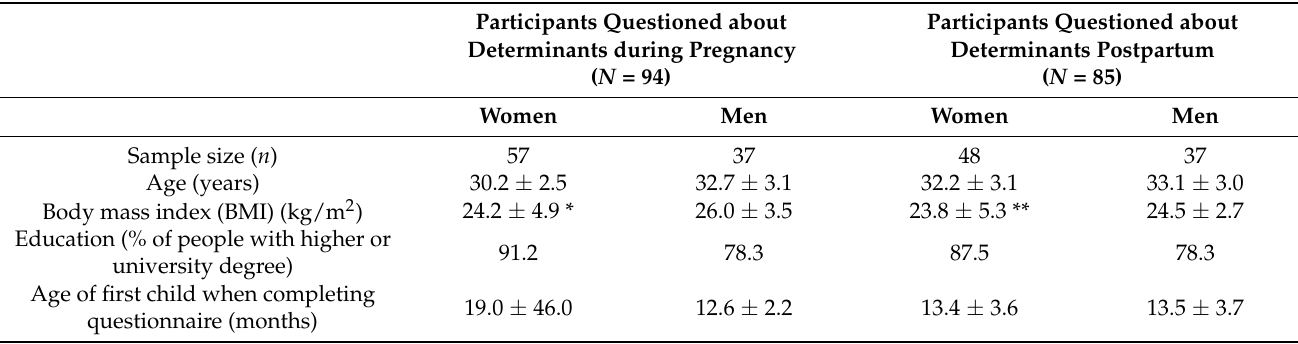
Figure 3. Parents’ rating of determinants of changes in eating behavior (mean ± SD; rated on a scale from 0 to 10) during the postpartum period. * Statistically significant sex differences. The colors of the bars depict the (sub)level of the determinants: blue for the individual level (darkest blue: biological sublevel, medium blue: psychological sublevel, lightest blue: situational sublevel), orange for the interpersonal level, and green for the environmental level. The left bar (i.e., darker color) of each determinant depicts the score for first-time mothers, and the right bar (i.e., lighter color) of each determinant depicts the score for first-time fathers. Table 1. Characteristics of the study sample of first-time